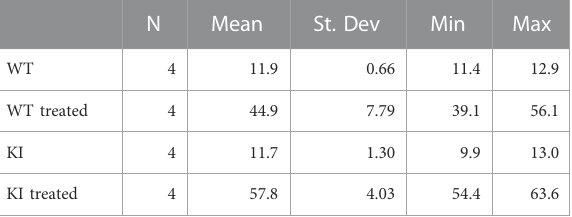
TABLE 2 Rhodamine Fluorescence Intensity (gray values) of 1-month-old 1st